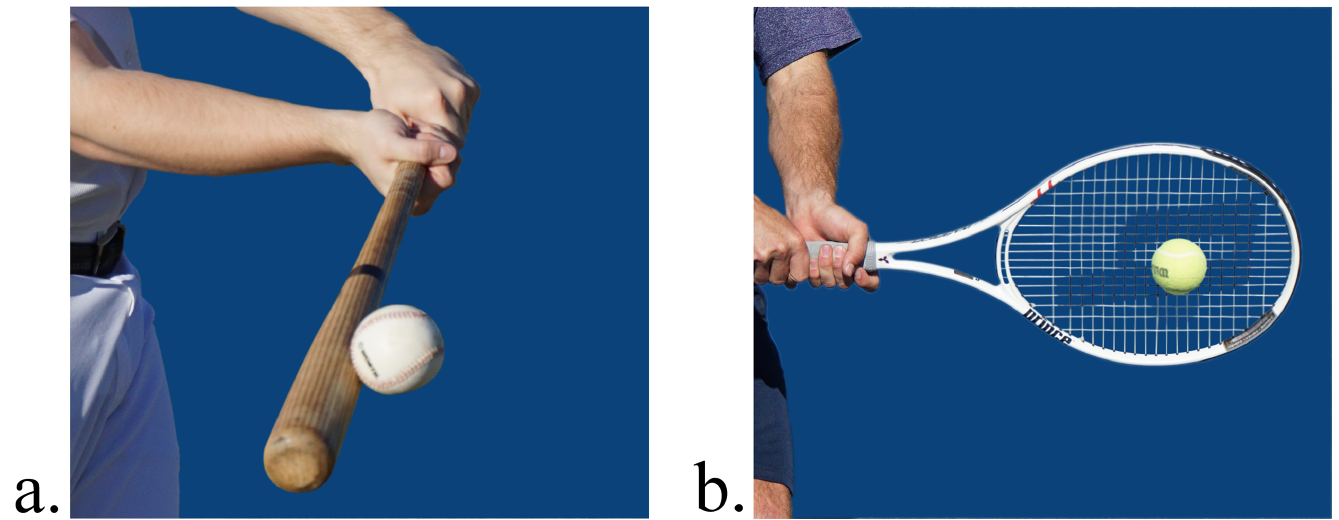
Fig 1. Stimuli. Visual stimuli depicting the (a) baseball task and (b) tennis